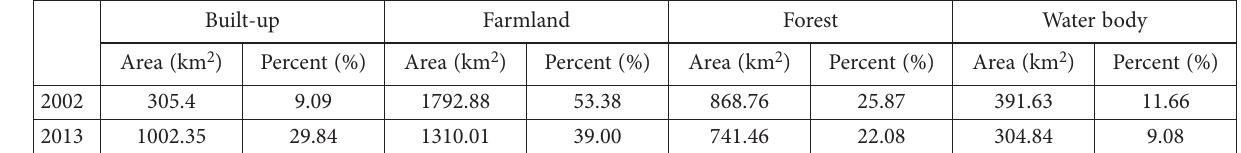
Table 4. Matrices of land cover changes in Hangzhou city from 2002 to 2013 (unit: km 2 ) Built-up